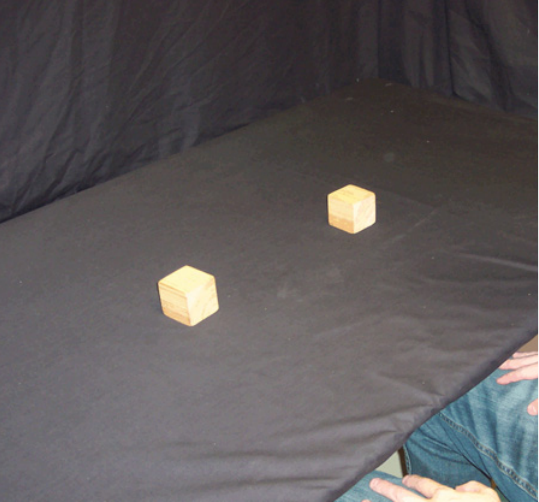
Fig 1. Blocks on the table. Blocks placed on the table 30 cm apart, at arm's